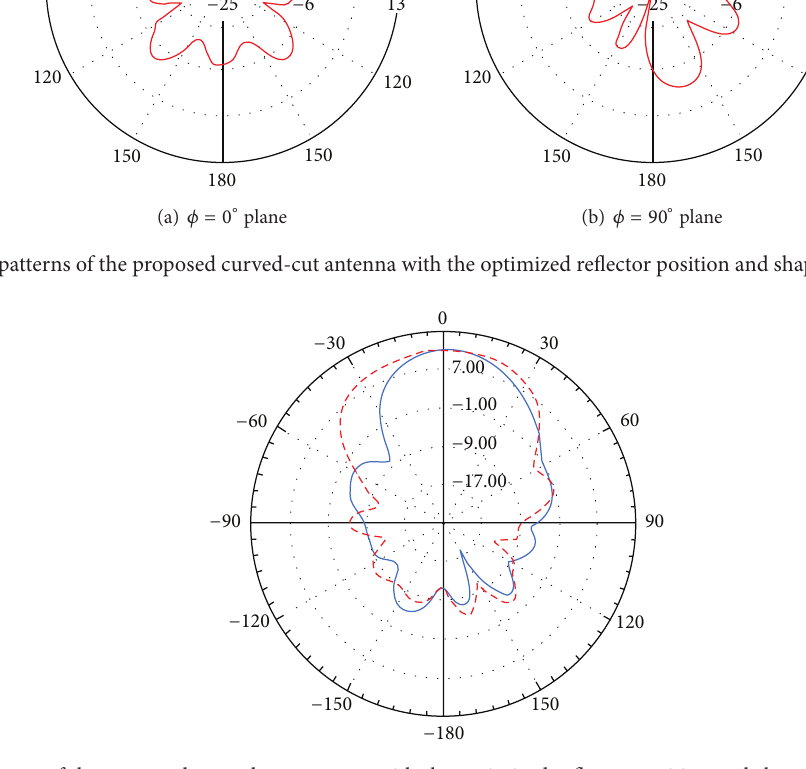
Figure 19: Gain patterns of the proposed curved-cut antenna with the optimized reflector position and shape, computed using HFSS: red (dashed) in 𝜙 = 0 ∘ plane and blue in 𝜙 = 90 ∘